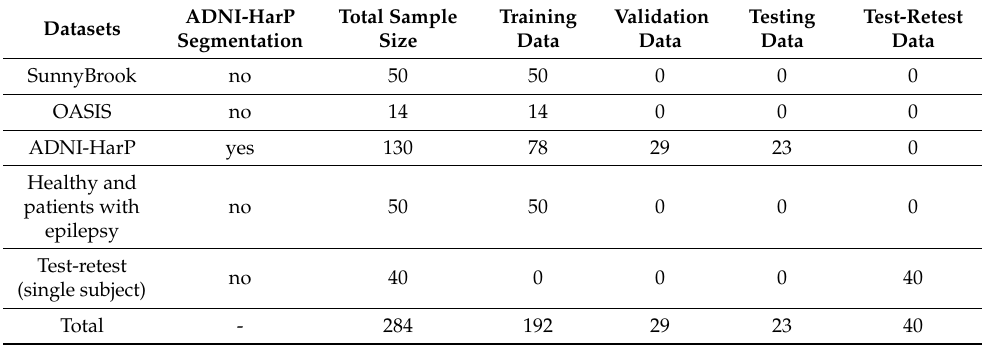
Table 1. Training, validation, testing, and test-retest data